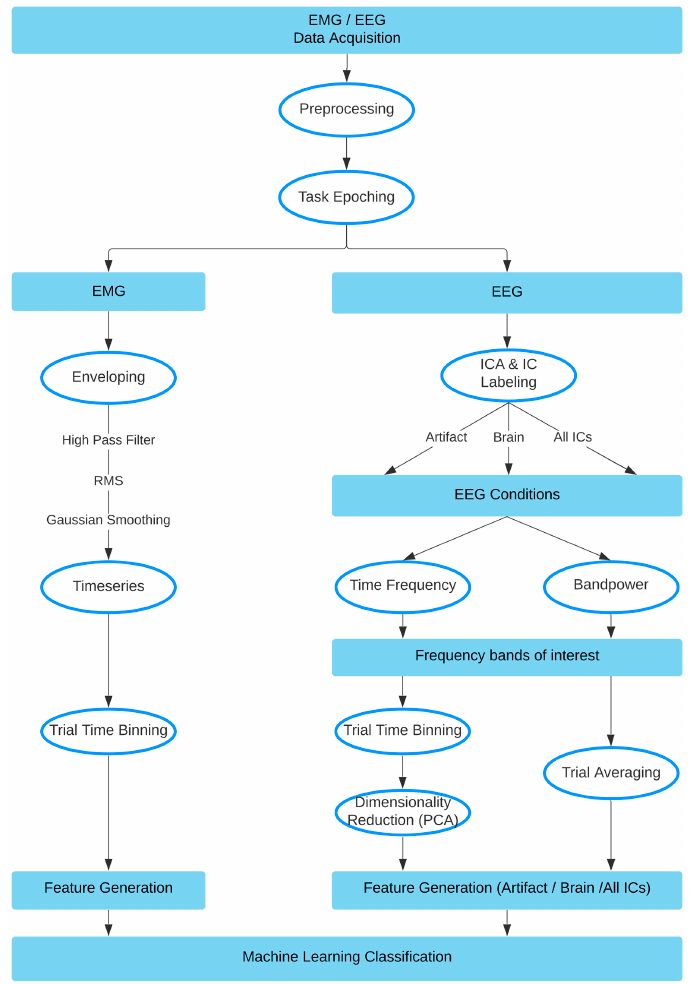
Figure 3. Method pipeline, data split into EMG and EEG